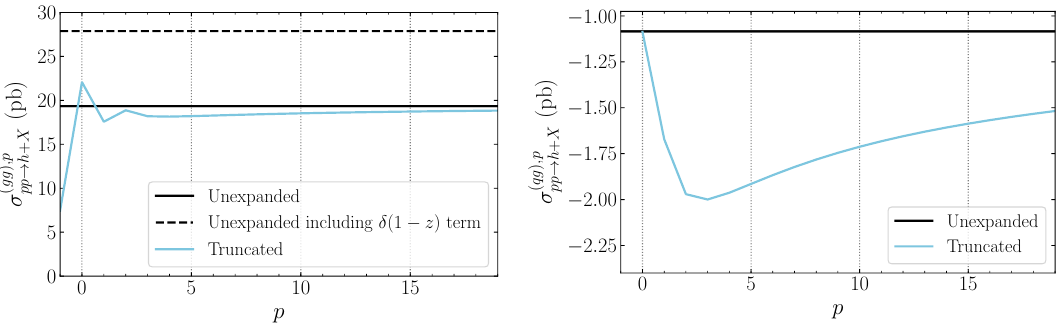
Figure 8. Power expansions of the NLO+NNLO hadronic cross sections for single Higgs production for Q = 125 GeV. The results are shown in a cumulative way: in the expansion up to power p , each power < p is included. The gg ( qg ) contribution is shown on the left(right)-hand side. The δ (1 − z ) contribution in the gg -channels is shown separately, and the LO contribution is not